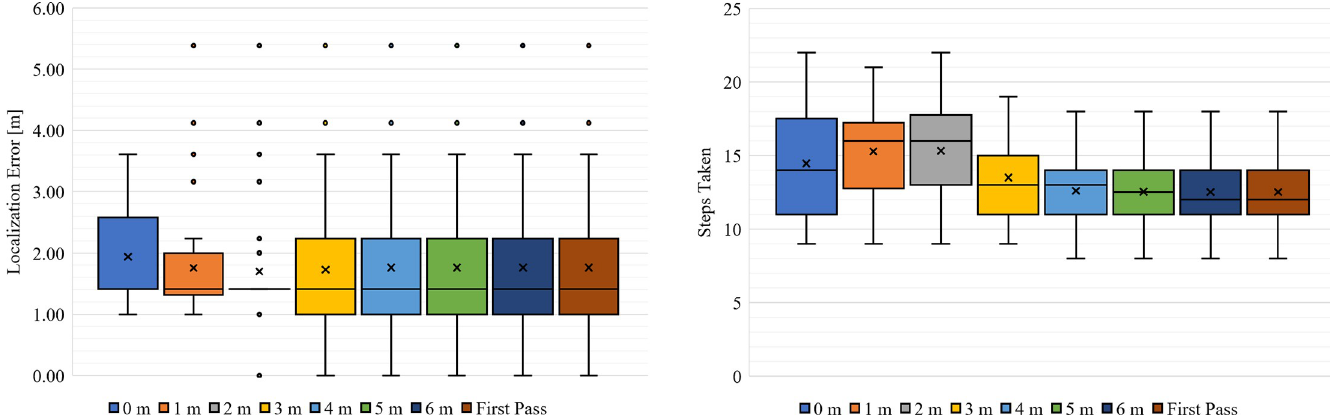
Fig 7. Localization error and steps taken for MLE-Bayesian approach. Whisker and box plots showing (A) the distribution of localization error and (B) steps taken to localize by the MLE-Bayesian method. The “x” marks the mean of the distribution.